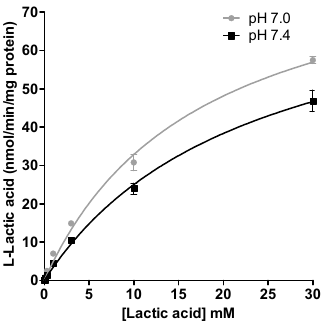
Figure 3. Kinetic parameters of L -lactic acid (0.03 to 30 mM) in SKMC determined at pH 7.0 and pH 7.4. Each point represents the mean ± S.D. of experiments performed in triplicate. 3.2. L -Lactic Acid Efflux Inhibition by Different Drugs